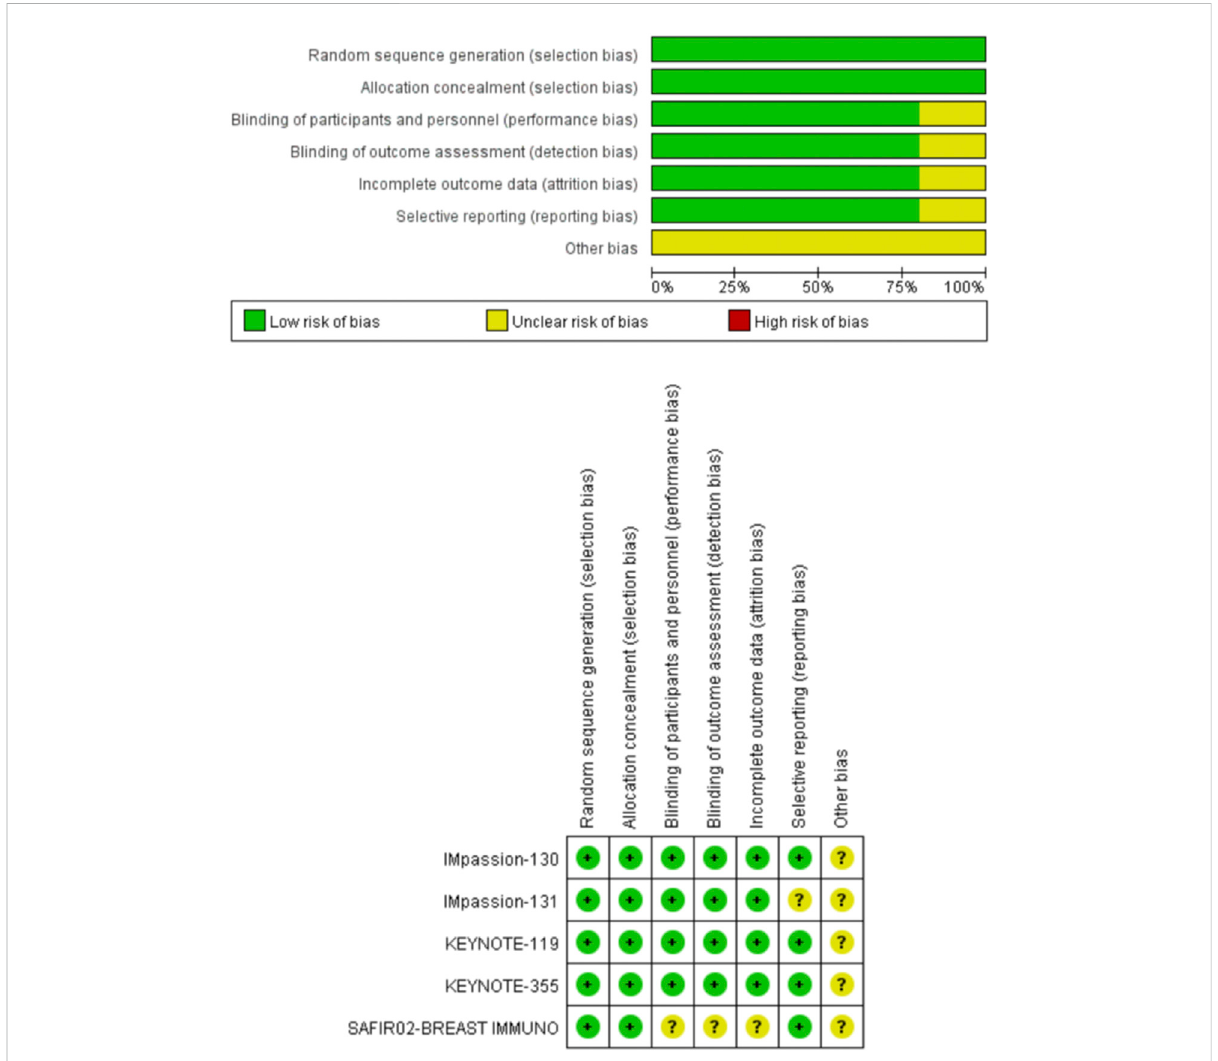
FIGURE 2 Quality assessment for risk of bias for the included randomized controlled